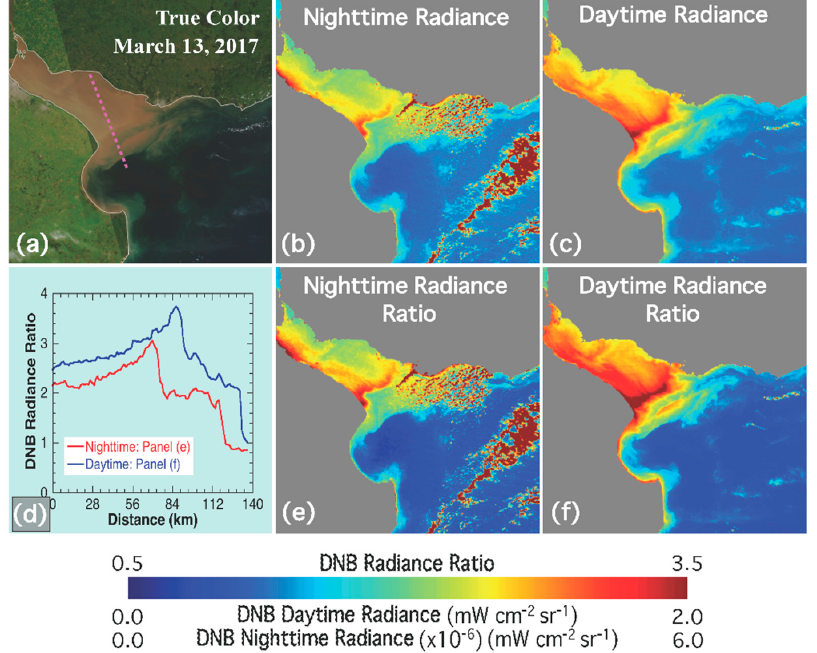
Figure 1. Visible Infrared Imaging Radiometer Suite (VIIRS)-observed diurnal change of the La Plata River Estuary for ( a ) reflective solar band (RSB) daytime true color image at 16:47 UTC on 13 March 2017, ( b ) Day/Night Band (DNB) nighttime top-of-atmosphere (TOA) radiance at 04:27 UTC on 13 March 2017, ( c ) DNB daytime TOA radiance at 16:47 UTC on 13 March 2017, ( d ) DNB radiance ratio R along the transect line indicated in Figure 1a, ( e ) DNB nighttime TOA radiance ratio at 04:27 UTC on 13 March 2017, and ( f ) DNB daytime TOA radiance ratio at 16:47 UTC on 13 March 2017.